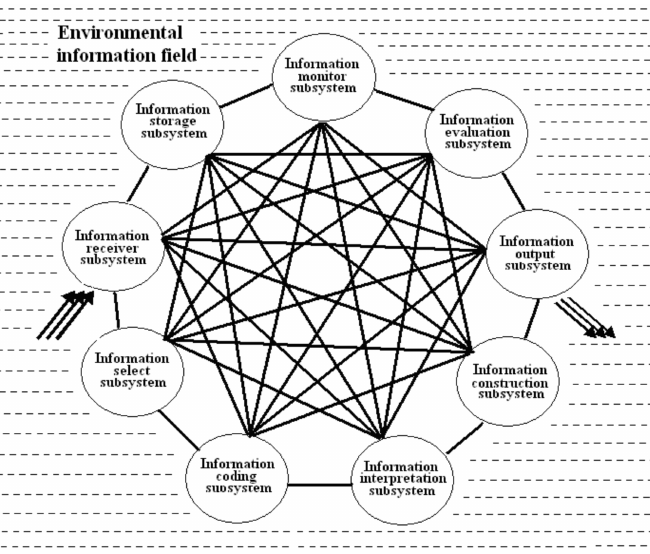
Figure 1. Information creation system structure model